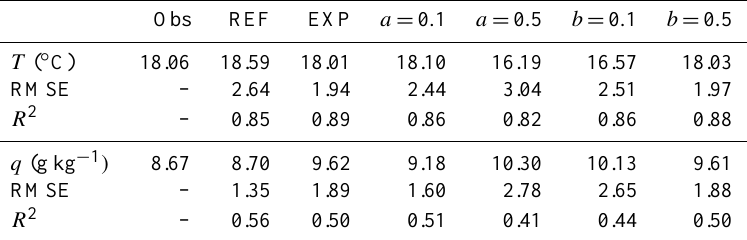
Table 4. Statistics for Melun for all the sensitivity